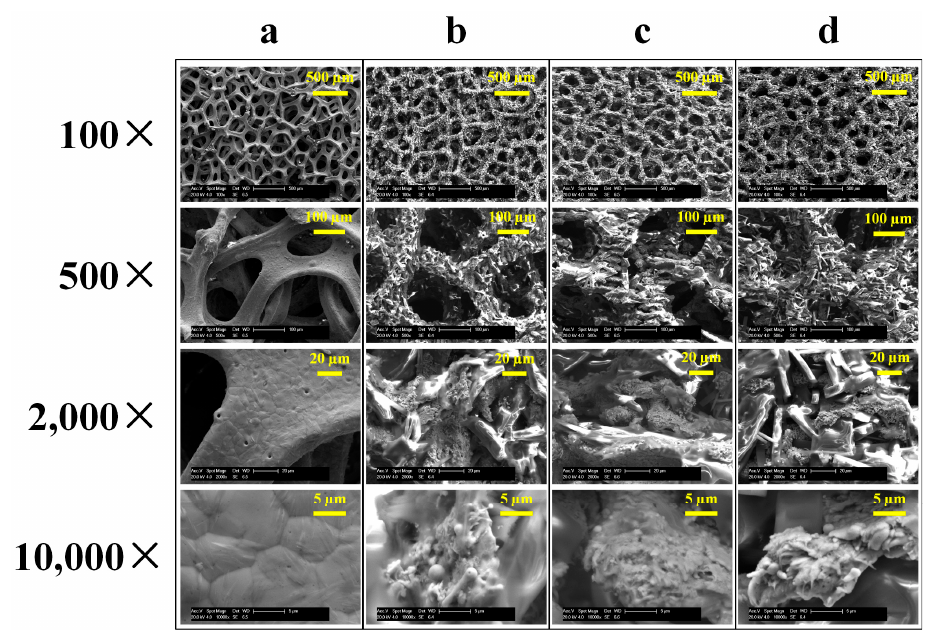
Figure 4. SEM micrographs at different magnifications for ( a ) untreated Cu foam and laser-heat treated Cu foams processed with different power levels ( b ) 8 W; ( c ) 10 W; ( d ) 12